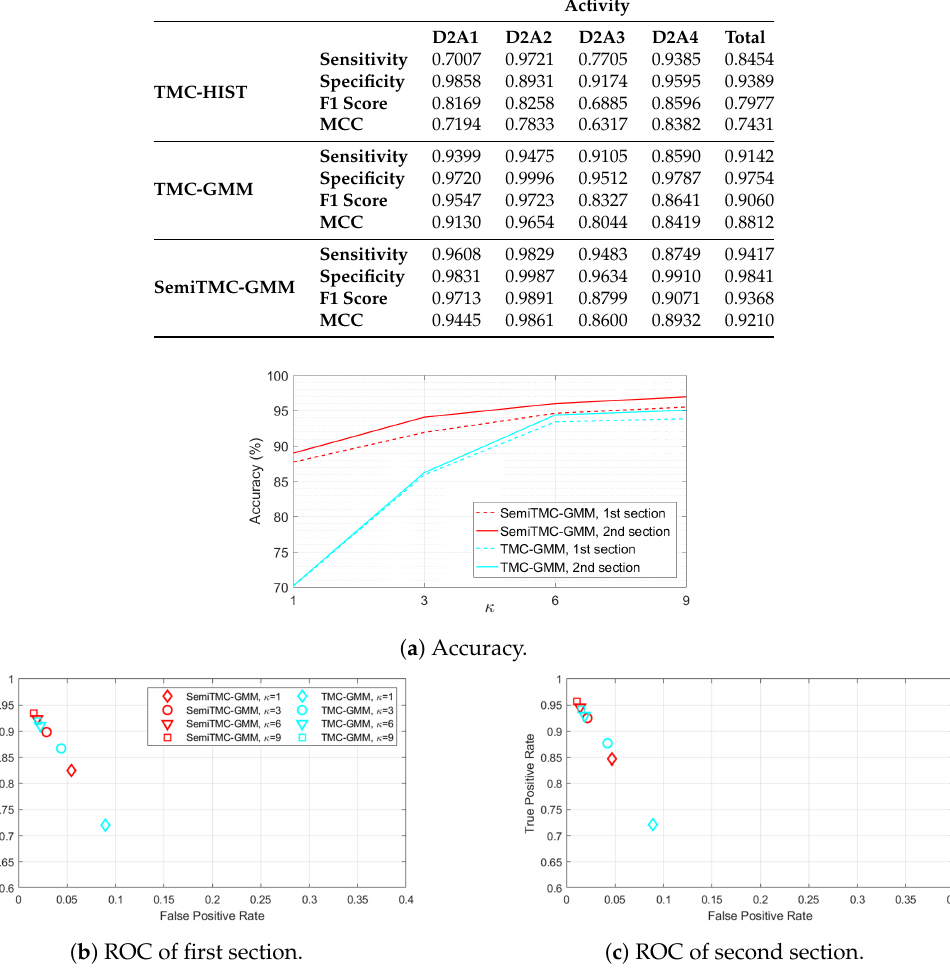
Figure 6. The on-line mode recognition performance of the two experiment sections in LMFIMU dataset, according to different GMM mixture number κ